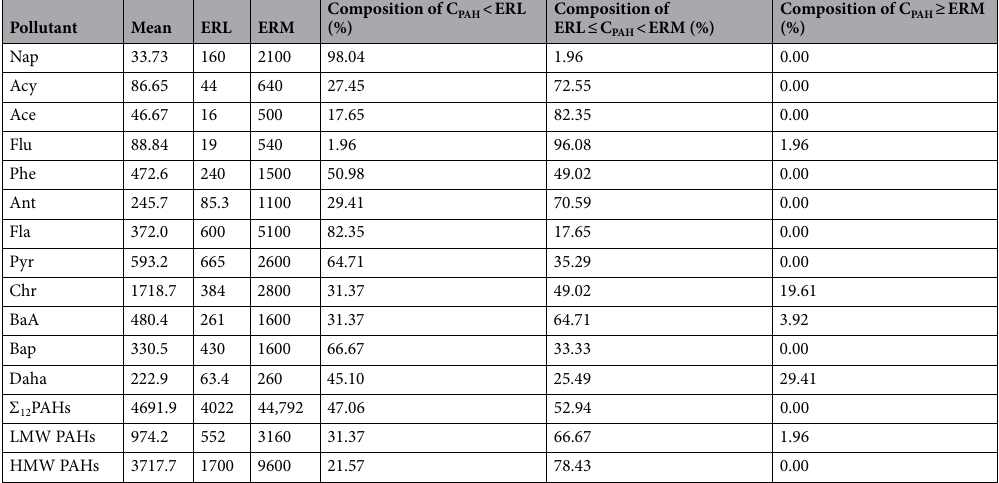
Table 3. Comparison of PAHs contents with ERL and ERM guideline values (ng g −1 ).